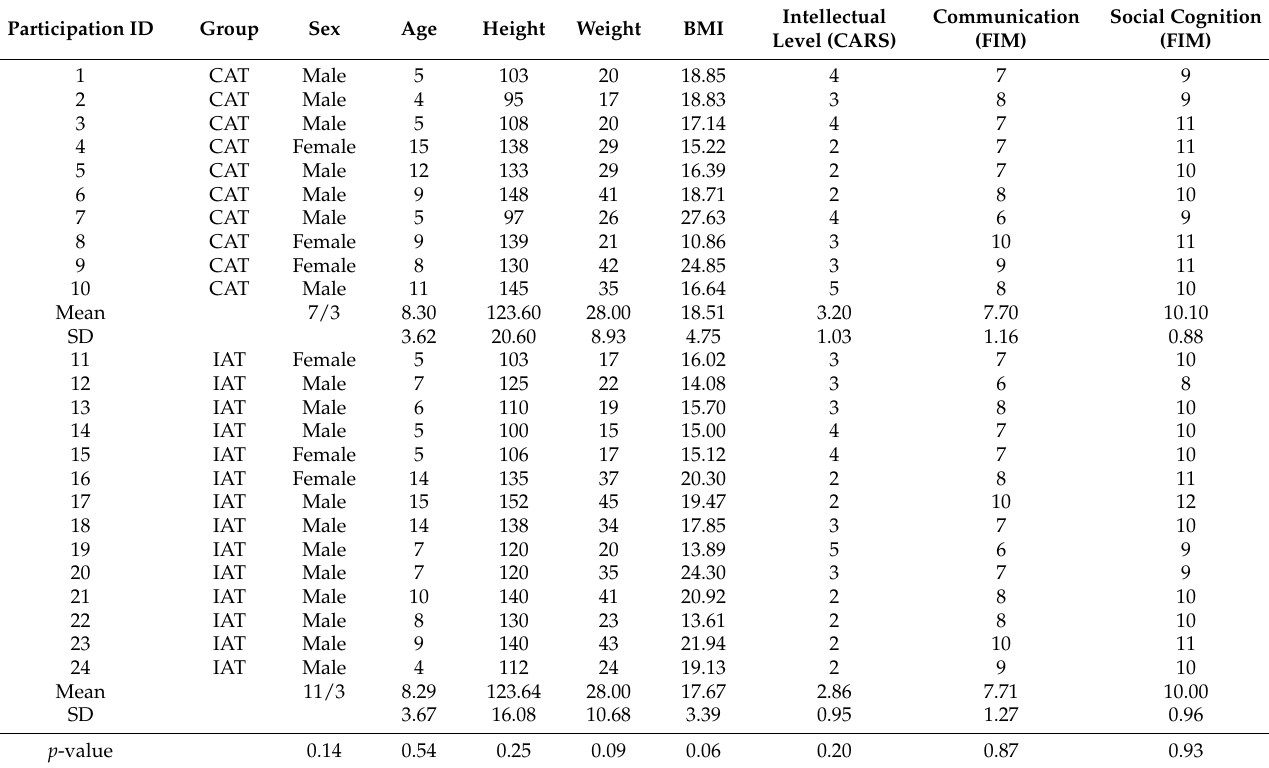
Table 1. Demographic and clinical characteristics of participants.